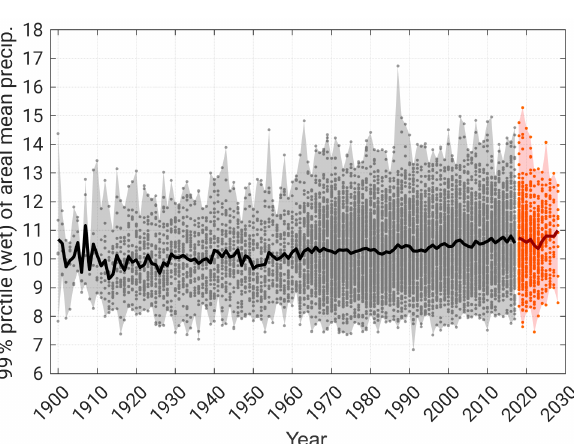
Figure 7. Time series of the yearly 99th percentile of daily spatial mean precipitation (wet days only) for Mid-Europe (ME; land only) of the LAERTES-EU ensemble mean (solid line), and the ensem- ble spread (minimum to maximum; dots and shaded area) during TP1 (1900–2017; black/gray) and TP2 (2018–2028;